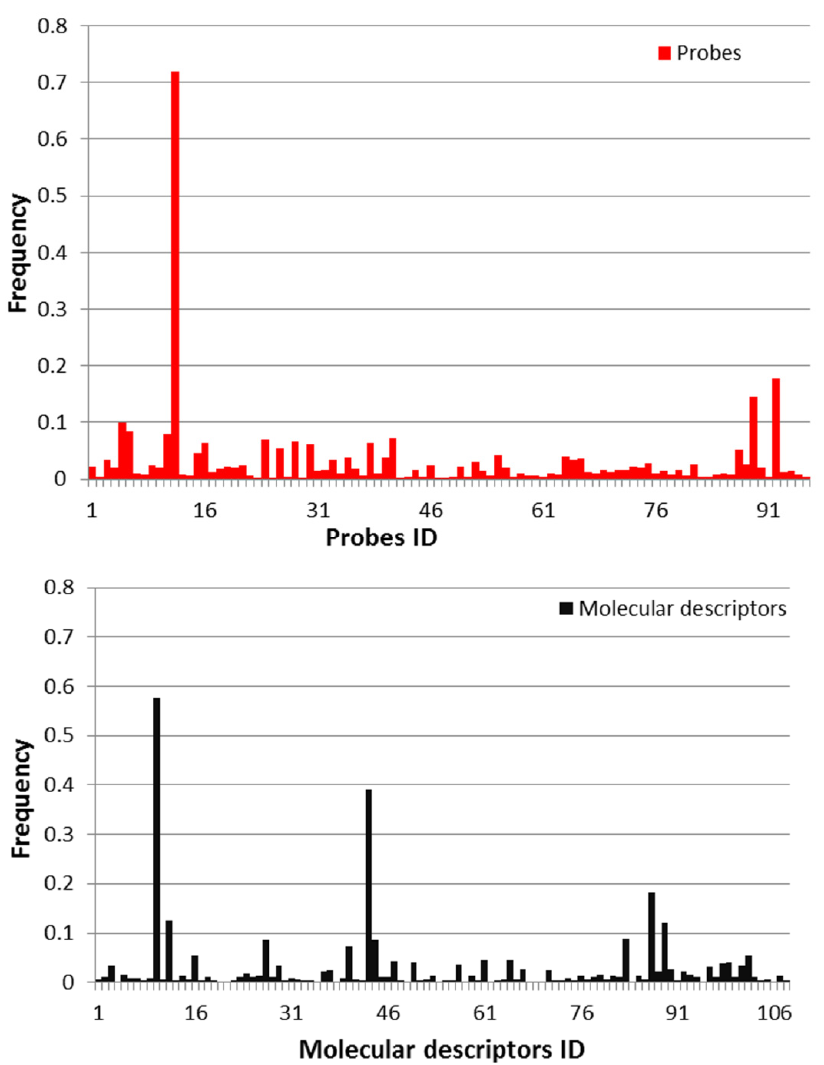
Figure 1. The frequency of features selected by equivalent models.